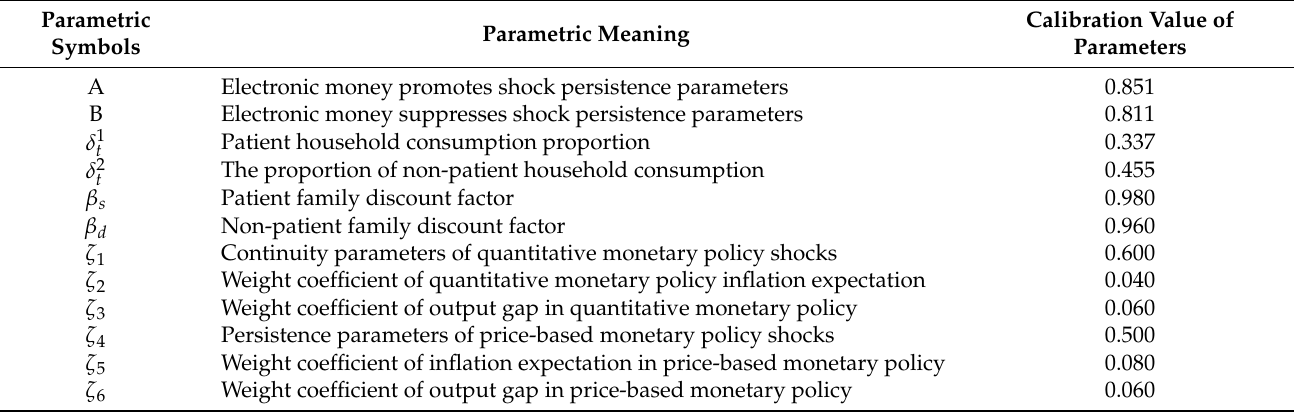
Table 1. Calibration value of